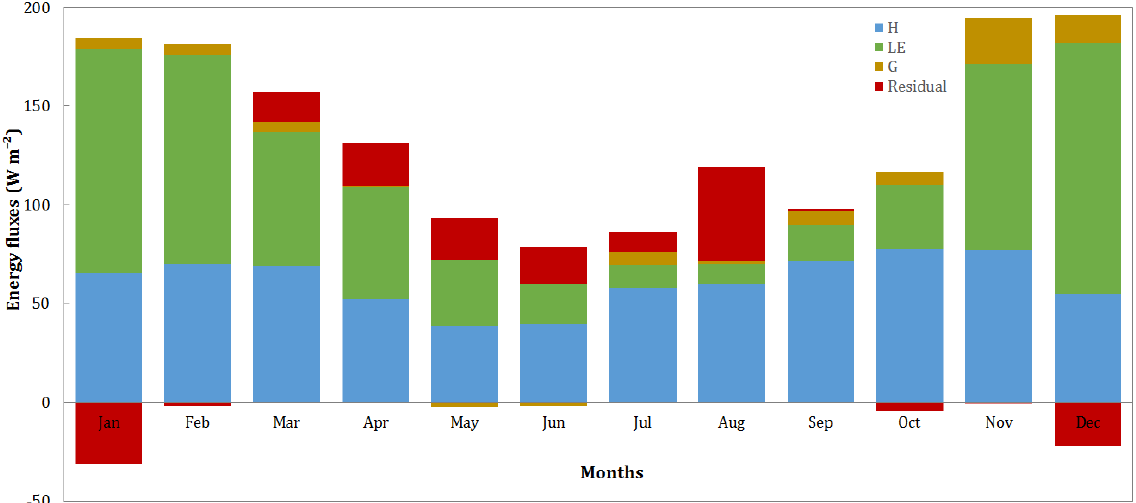
Figure 7. The 15-year (2000–2014) monthly means of surface energy balance fluxes of Skukuza flux tower site (SA), highlighting the partitioning of